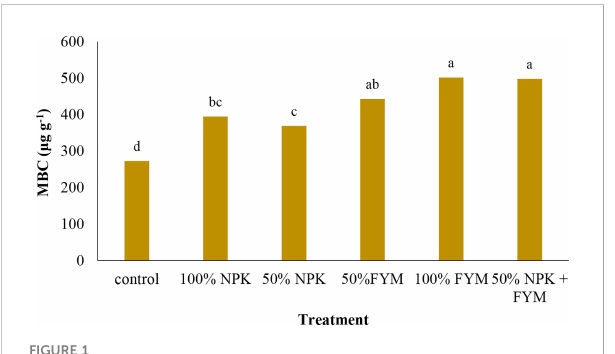
FIGURE 1 Effect of long-term fertilization and manuring on soil microbial biomass carbon.